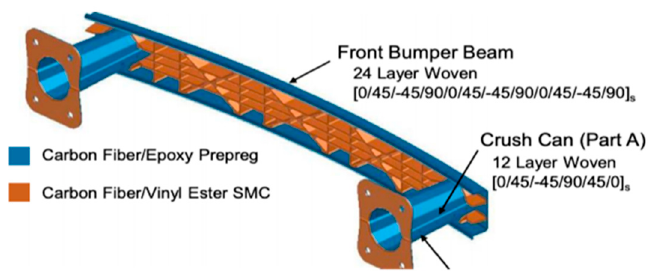
Figure 1. CFRP crush cans attached to composite bumpers [1].